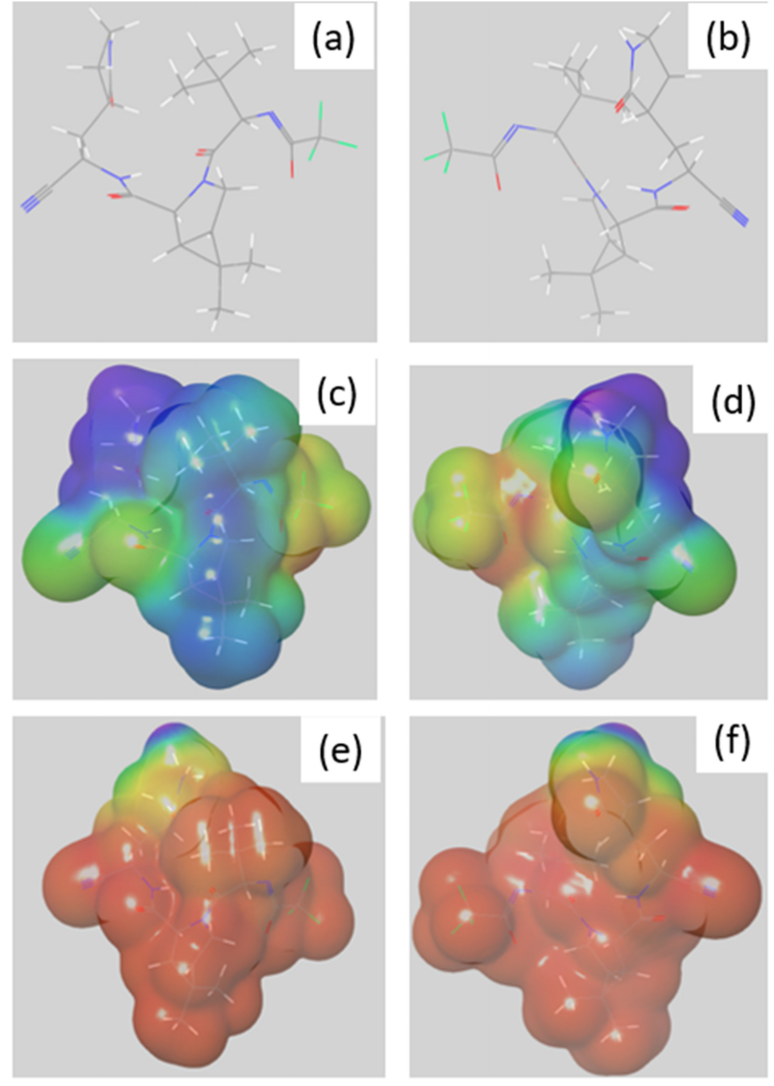
Figure 9. ( a , b ) Structure of optimized geometry of nirmatrelvir’s main conformer at pH = 13; ( c , d ) associated mapped electrostatic potential; and ( e , f ) mapped Fukui f + function. Regions with lowest and highest values are mapped in red and purple,